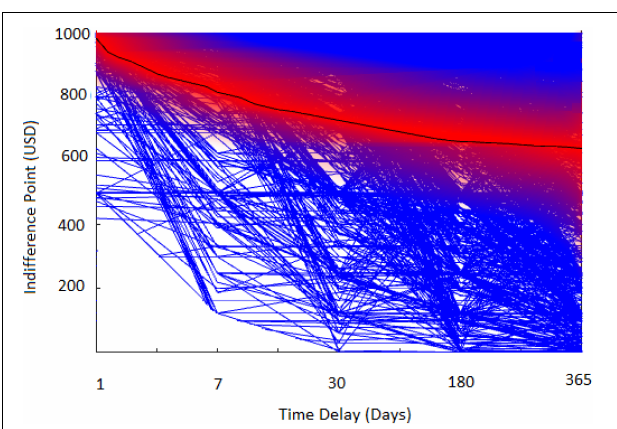
FIGURE 3 | Visualization of discounting of future rewards based on points of indifference between delayed future reward ($1,000) and discounted immediate reward. Blue lines represent each study participant’s indifference function; the black line is the average discounting curve with standard error denoted by the color red.